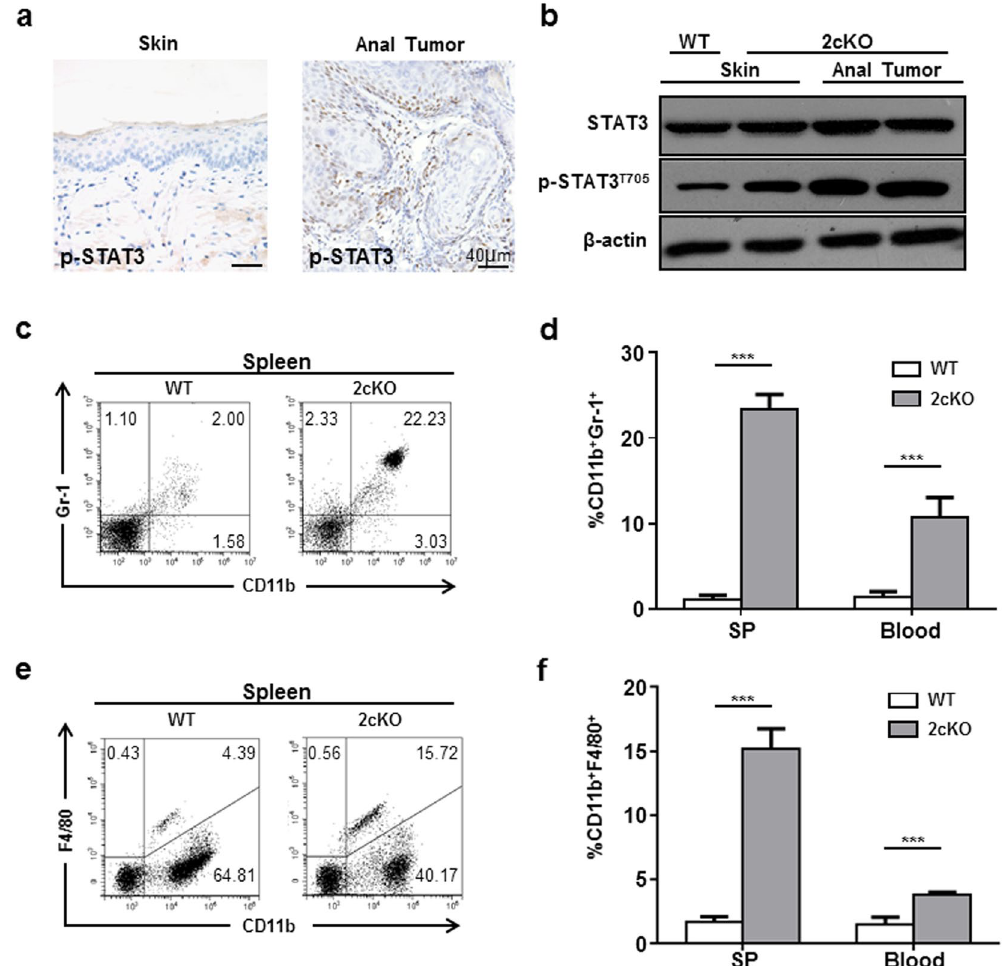
Figure 2. MDSC and TAM populations were expanded in mice with ASCC. ( a ) Immunohistochemical staining of the perianal skin and anal tumor showed that p-STAT3 was upregulated in both cancer cells and infiltrating immune cells in anal tumor ( b ) Western blot showed the phosphorylation level of STAT3 was upregulated in mice with the anal tumor. ( c , d ) CD11b + Gr-1 + MDSC population was expanded in spleen and blood of mice with ASCC. ( e , f ) CD11b + F4/80 + TAM population was expanded in spleen and blood of mice with ASCC. *** P <